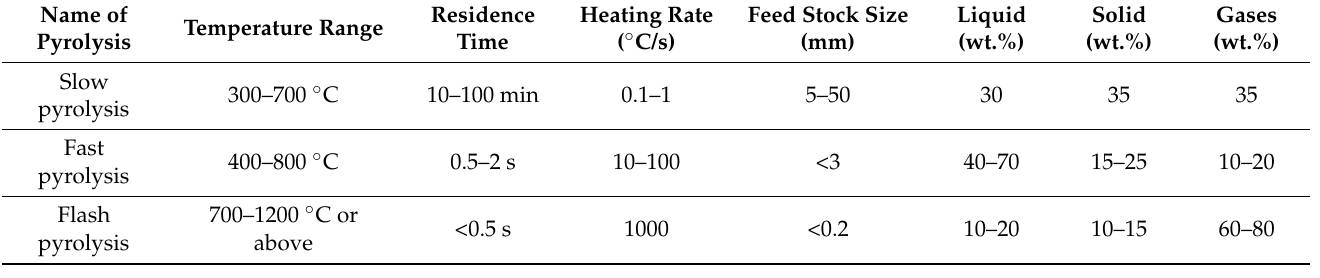
Table 2. Recent developments in the pyrolysis process [57,58].